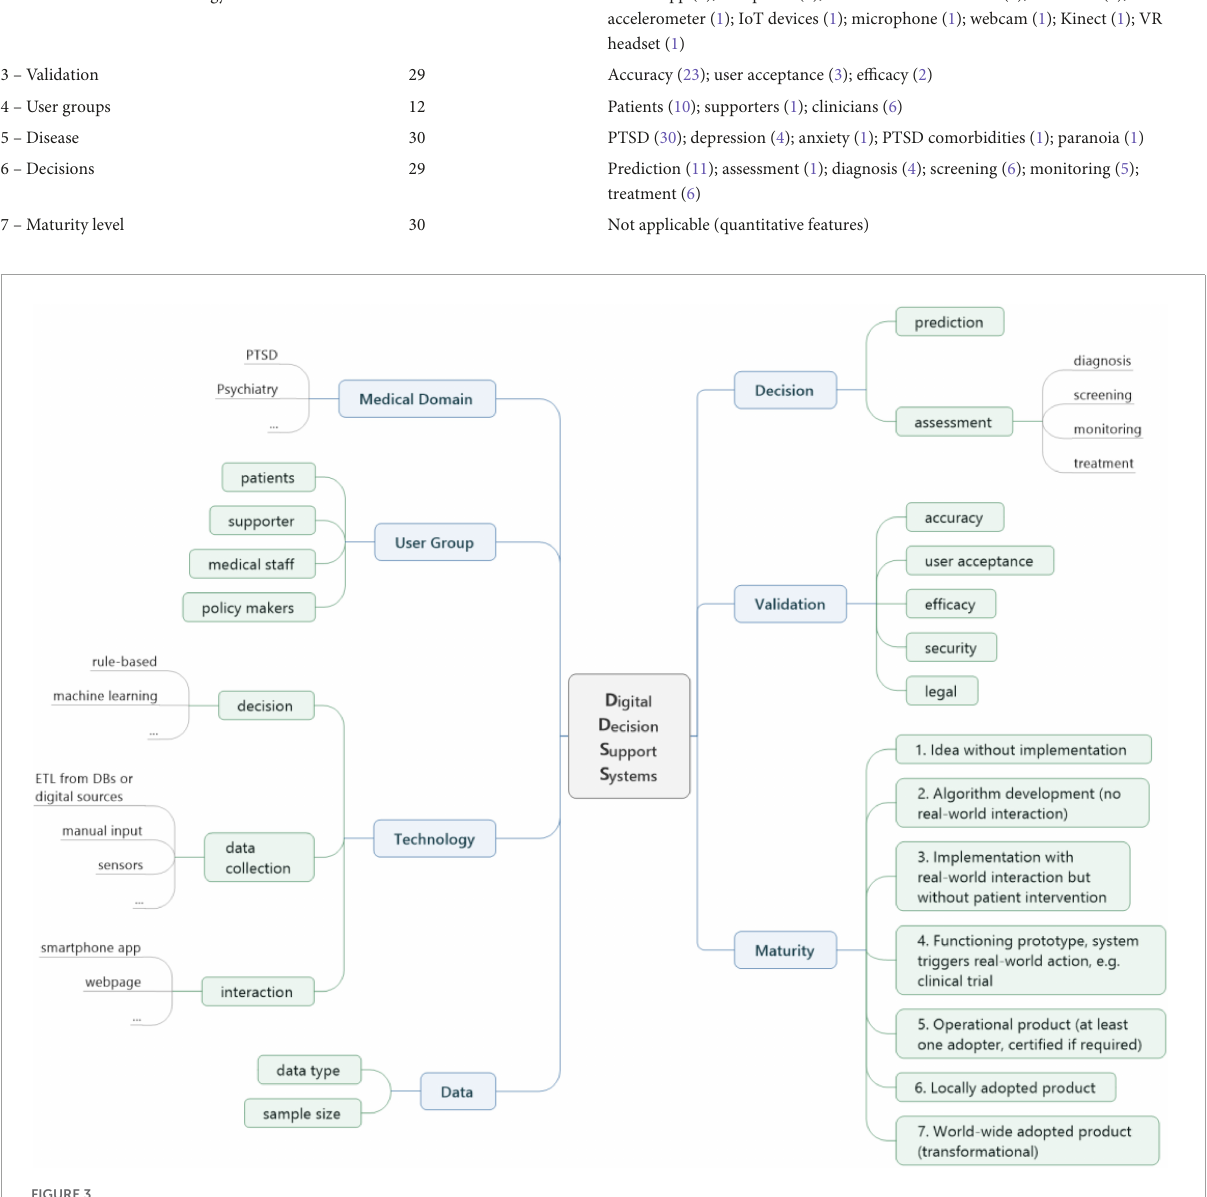
FIGURE3 Framework for